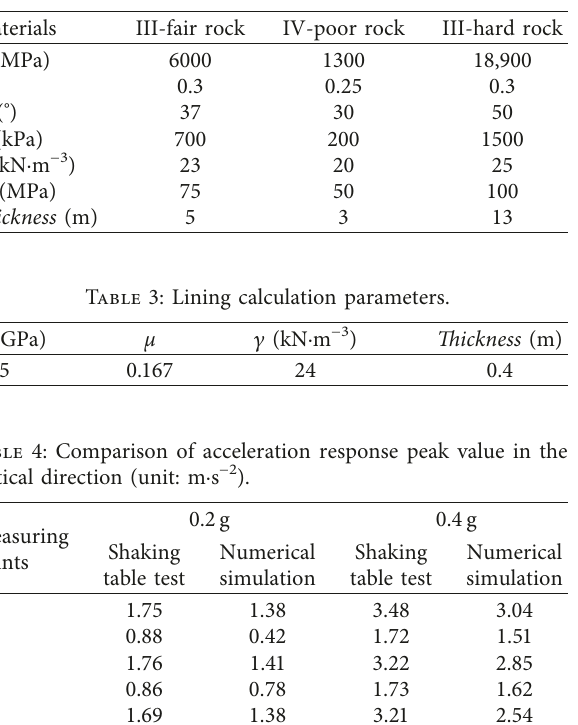
Table 2: Rock material parameters.